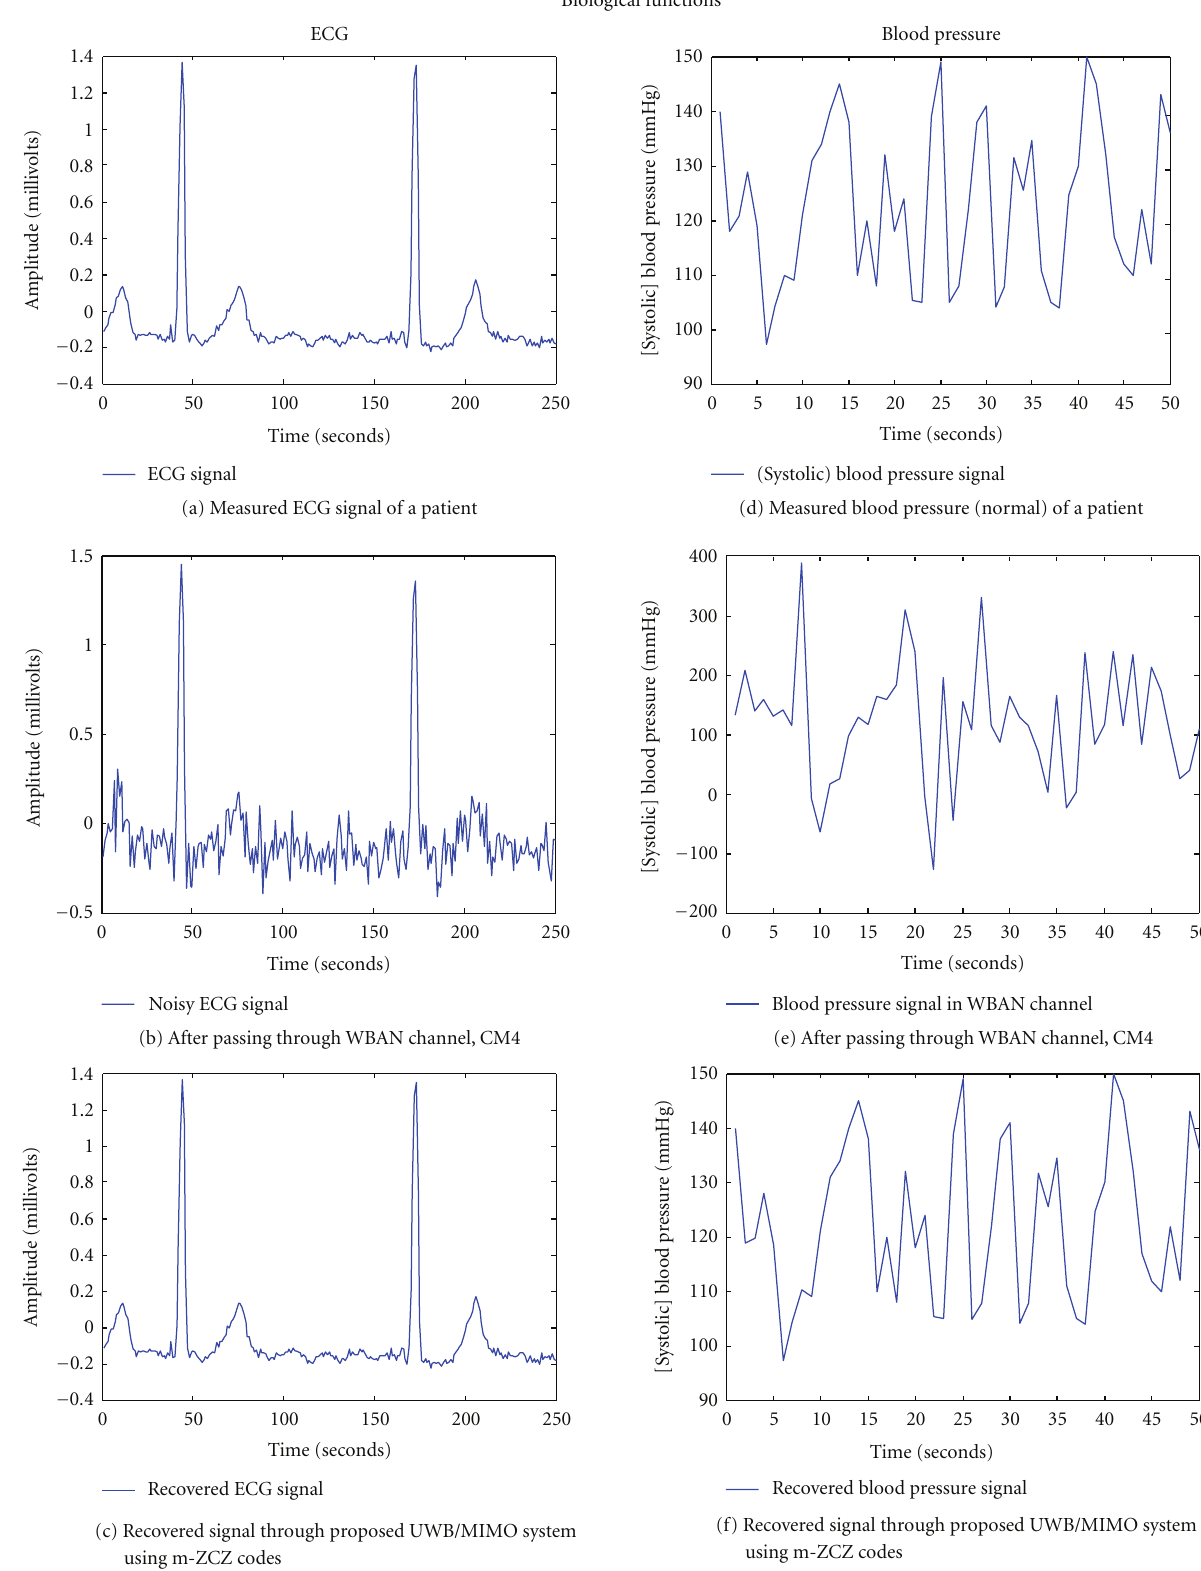
Figure 7: Transmission/reception of sample biological functions of patients through PPM TH-ZCZ UWB/MIMO (2 × 2)